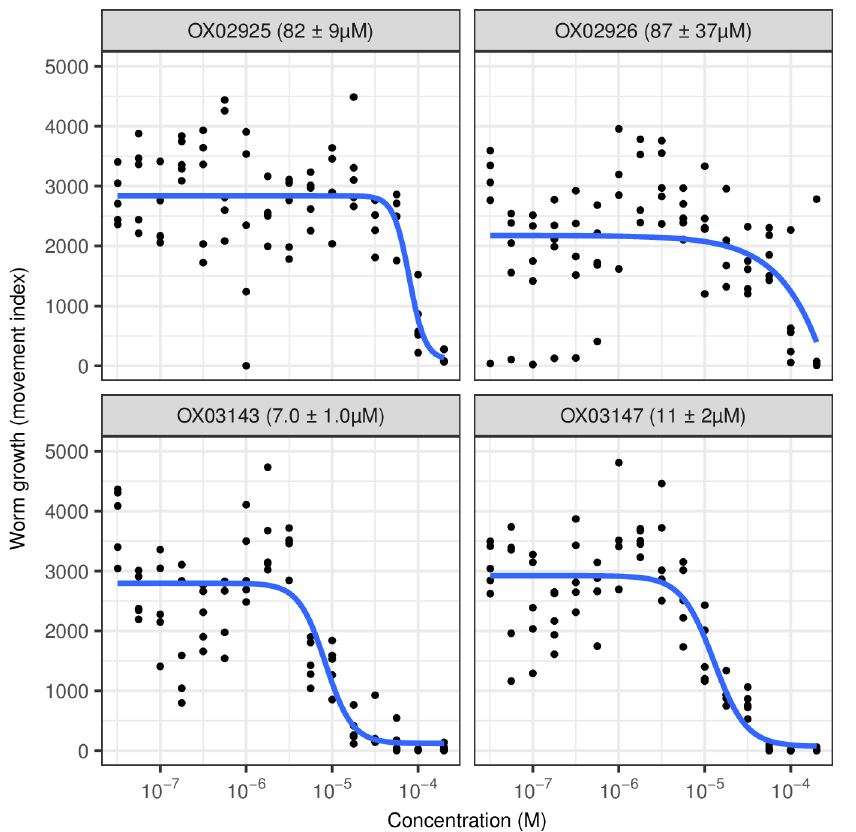
Fig 5. Concentration-response curves for resynthesized DATPs in the C . elegans growth assay. n = 5 wells per concentration per compound, each replicate on a different 96-well plate. Blue line indicates concentration-response curve fitted with the 4-factor log-logistic model using drc [16]. Figure in parenthesis indicates EC 50 estimate ± standard error from this model.